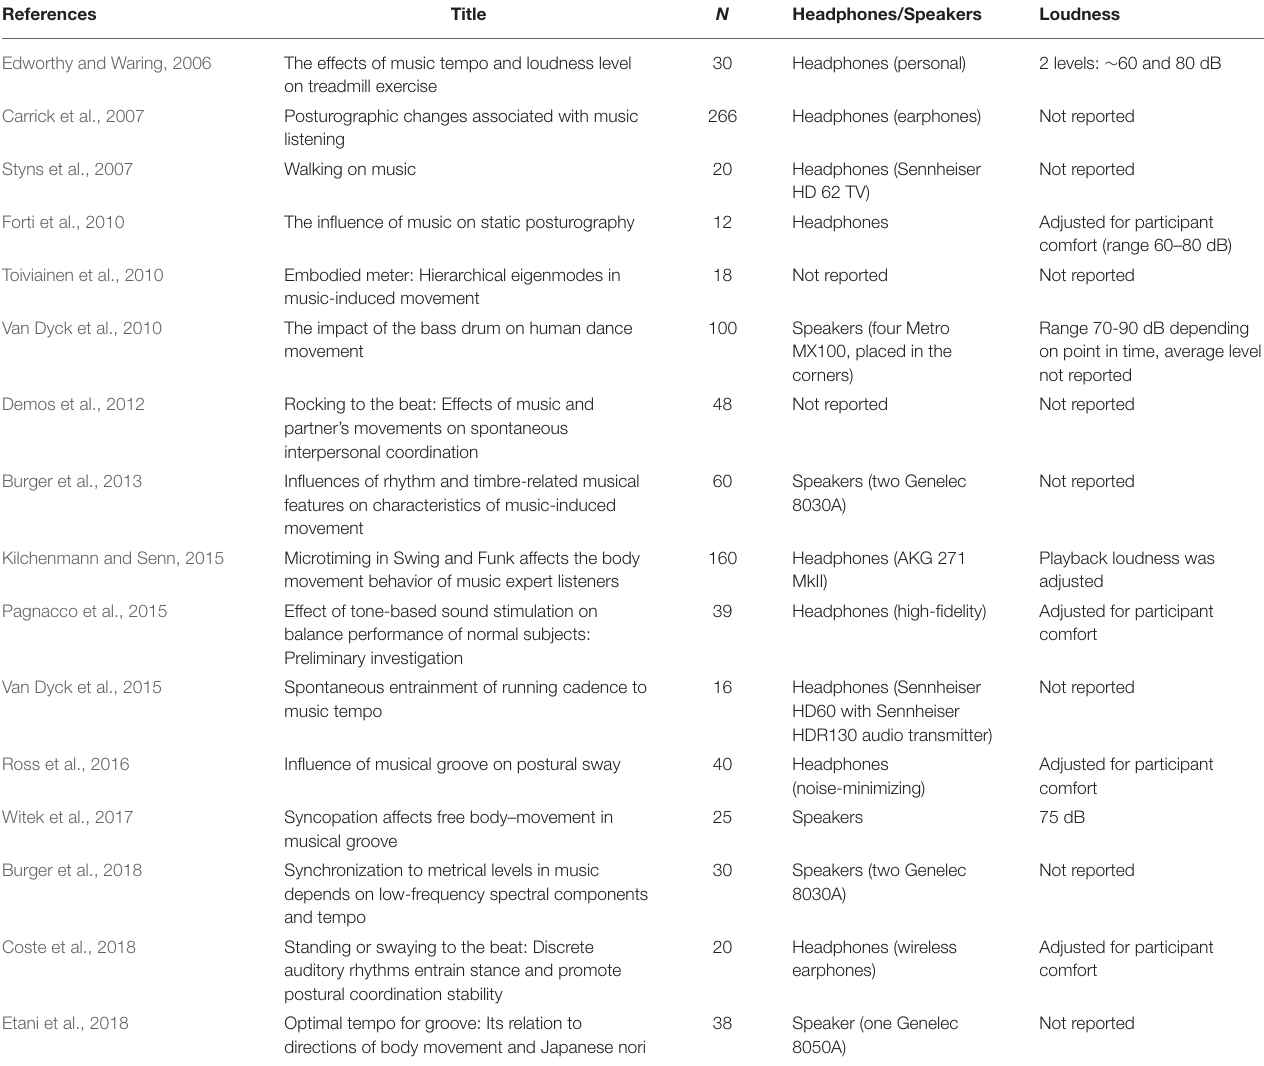
TABLE 1 | An overview of some relevant studies on body movement in response to